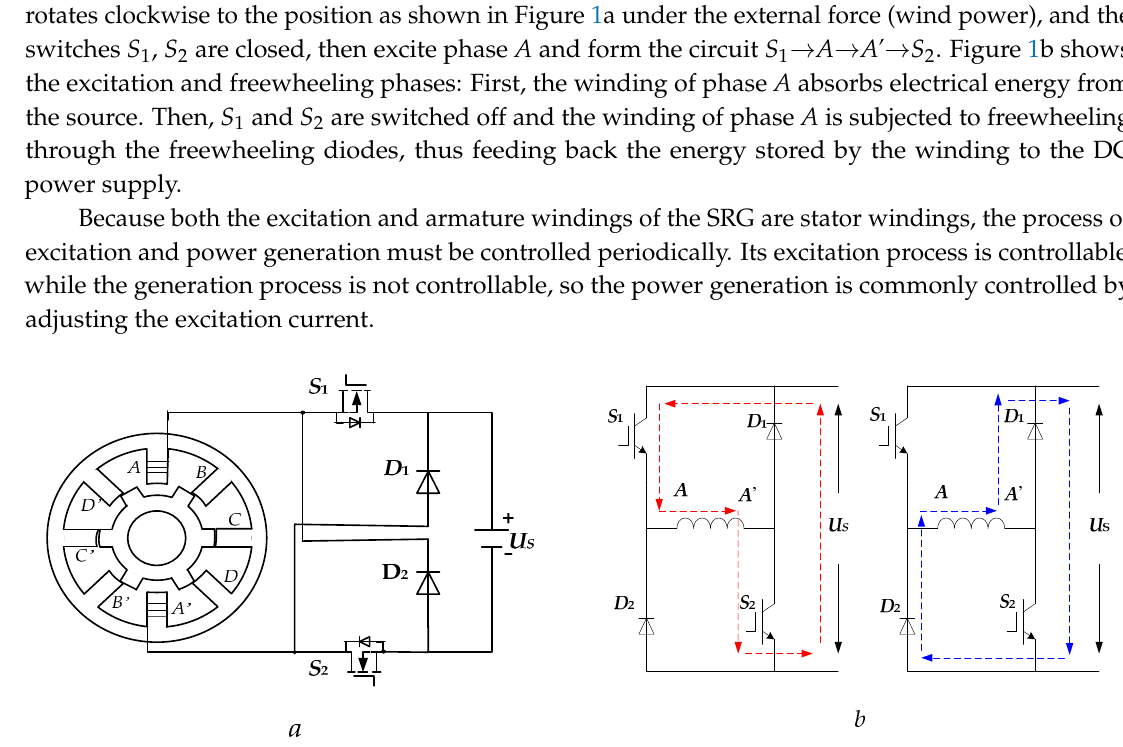
Figure 1. Principles of SRG. ( a ) Profile of 8/6 SRG; ( b ) two phases of SRG.